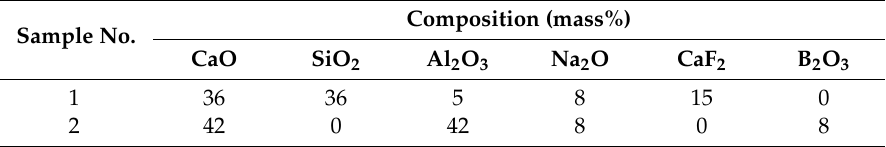
Table 1. The chemical compositions of the investigated mold fluxes.